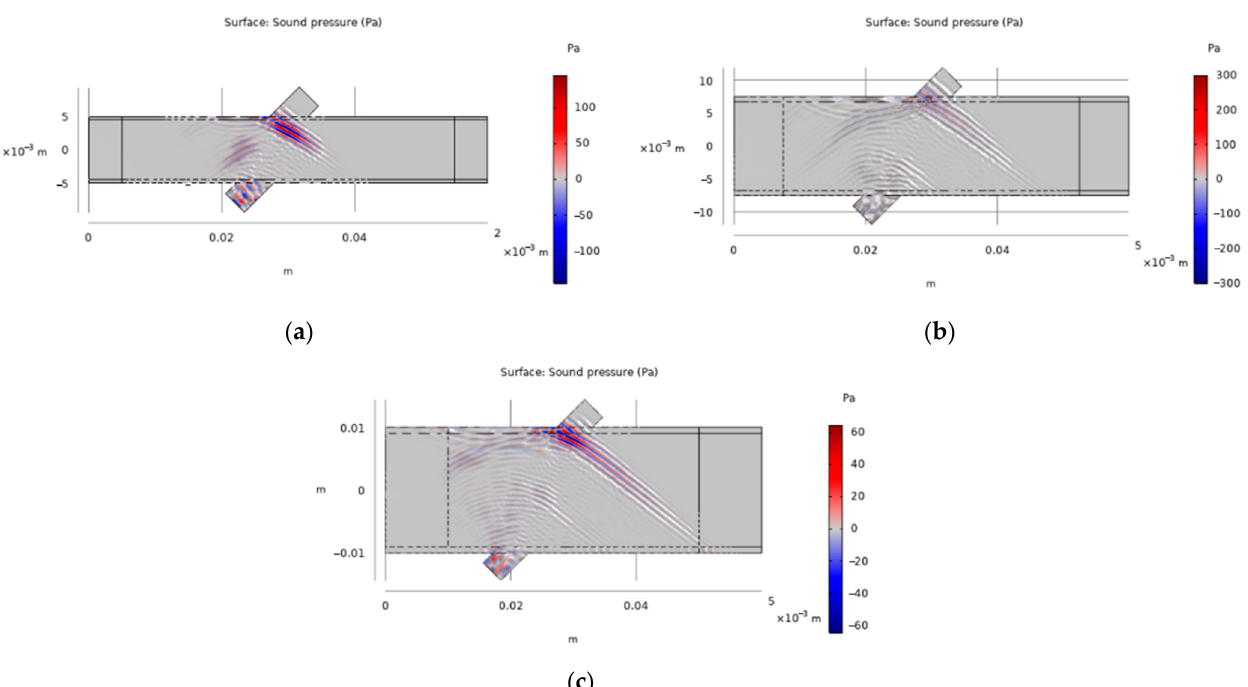
Figure 4. ( a ) Schematic diagram of sound pressure propagation of 10 mm pipe diameter; ( b ) Schematic diagram of sound pressure propagation of 15 mm pipe diameter; ( c ) Schematic diagram of sound pressure propagation of 20 mm pipe diameter.